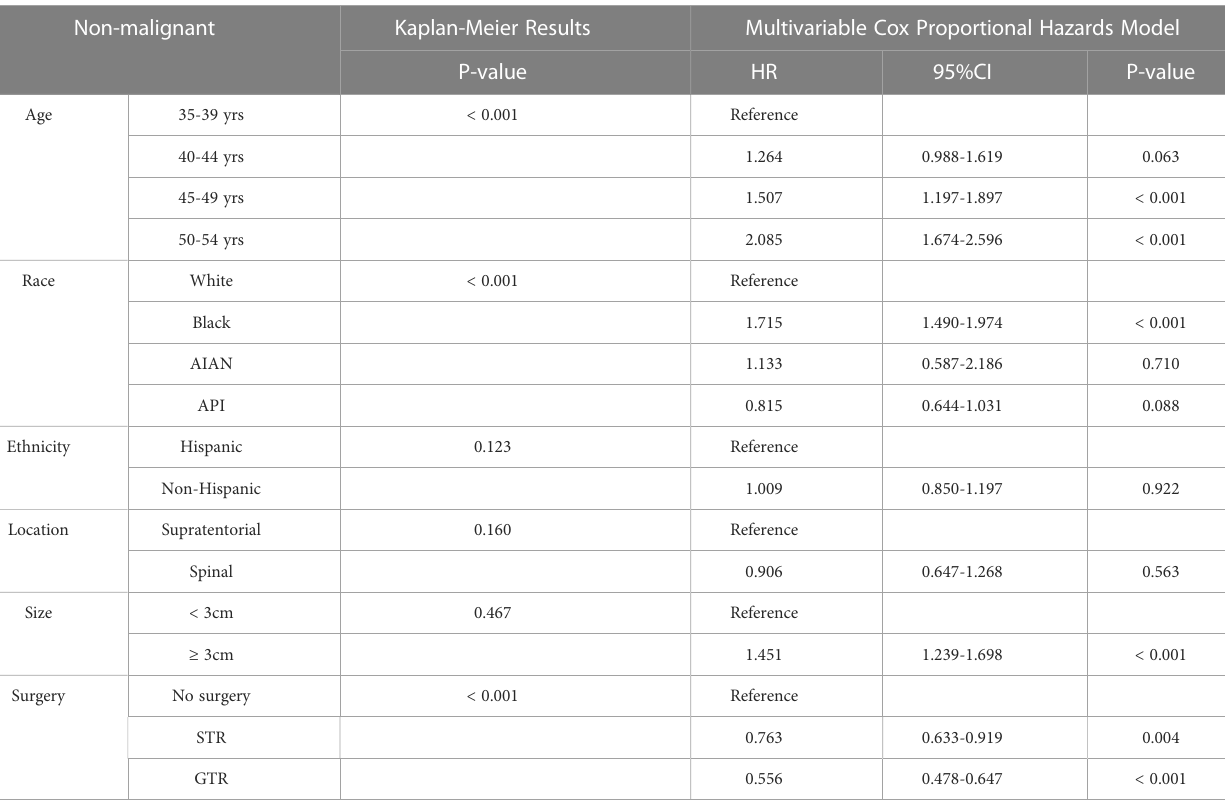
TABLE 2 Hazard rations (HR) and 95% con fi dence intervals (CIs) for patient demographics and treatment modalities in Multivariable Cox Proportional Hazards Model for middle-aged female non-malignant meningiomas